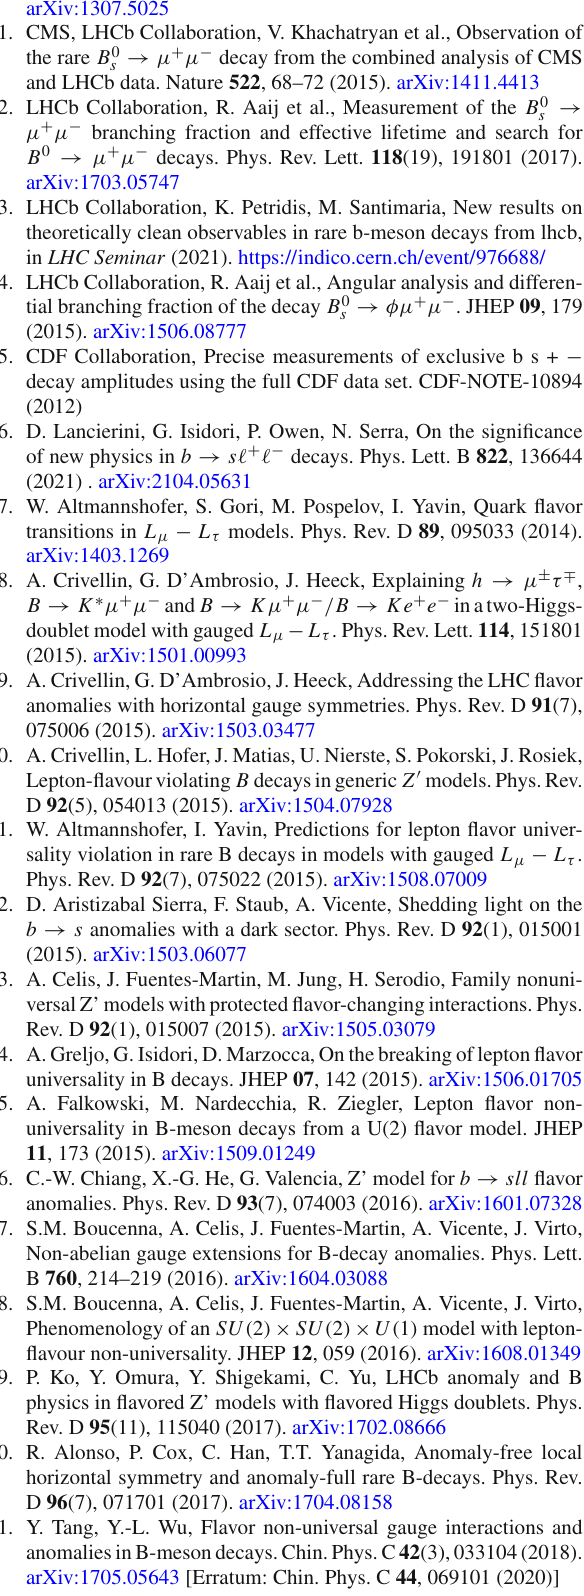
/ M 2 ) relative Z Z (cid:2)